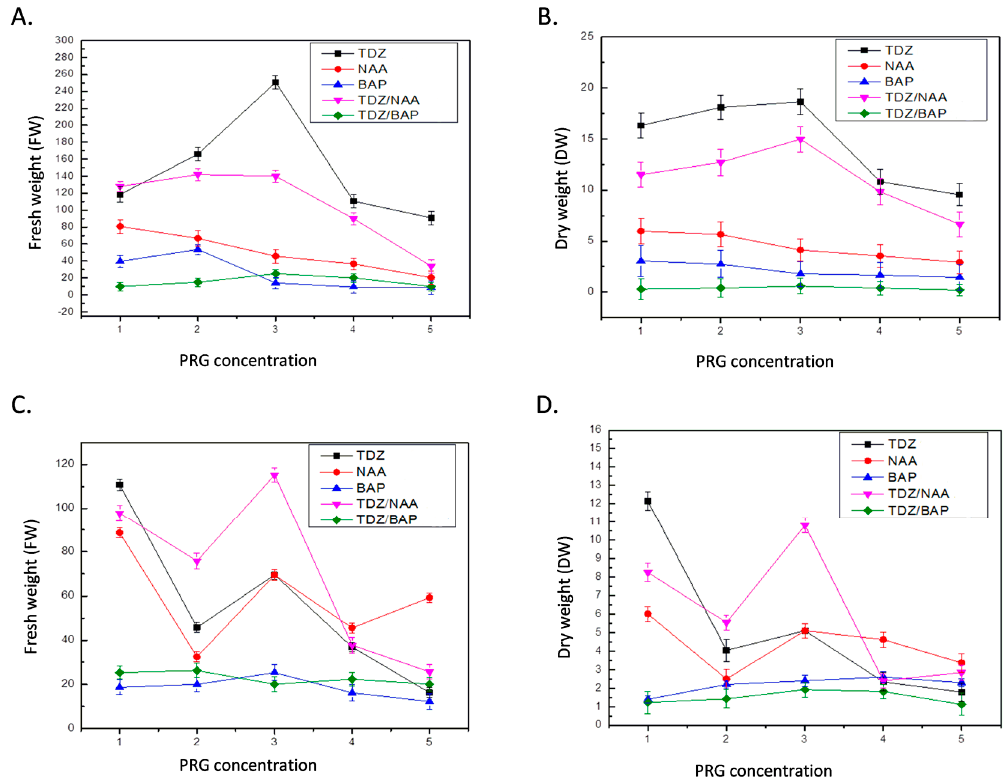
Figure 2. Time-course fresh and dry weight of callus cultures at different PGRs (in mg/L). ( A ) Fresh weight for stem-derived callus culture (in g/L); ( B ) dry weight for stem-derived callus culture (in g/L); ( C ) fresh weight for leaf-derived callus culture (in g/L); and ( D ) dry weight for leaf-derived callus (in g/L) cultured on MS medium fortified with TDZ, NAA, BAP (1.0–5.0 mg/L), TDZ (1.0 mg/L) + NAA (1.0–5.0 mg/L), TDZ (1.0 mg/L) + BAP (1.0–5.0 mg/L). Values are means of three replicates with standard deviation.